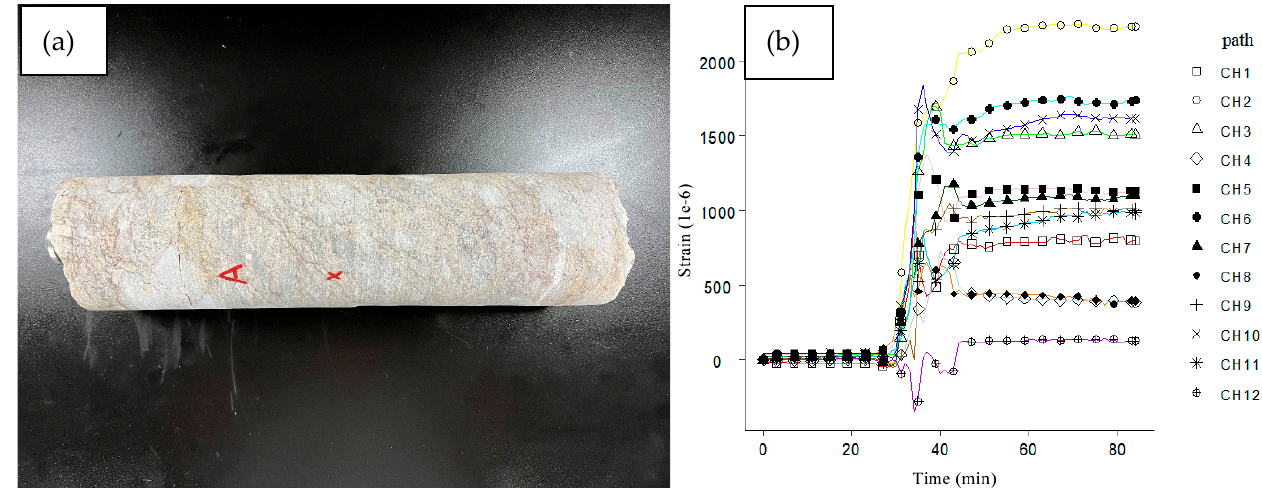
Figure 5. (a) Core; (b) Stress relief curve. Figure 5. ( a ) Core; ( b ) Stress relief